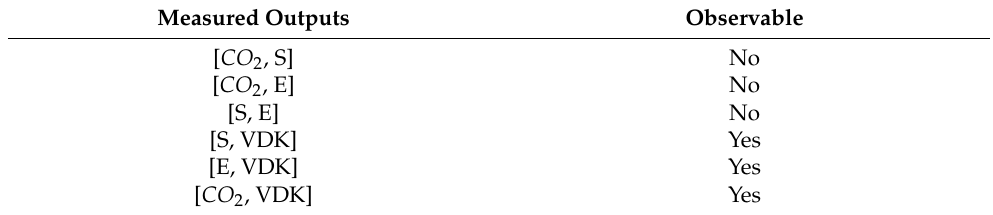
Table 4. Observability analysis of the carbon dioxide model for several measurement